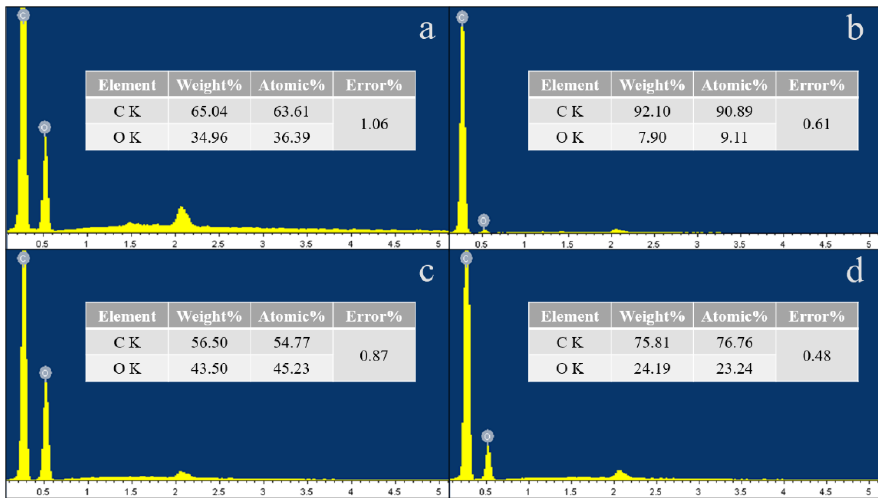
Figure 3. Changes in the oxygen content of PBAT and PS MP particles before and after UV aging (( a ) P-PBAT, ( b ) P-PS, ( c ) A-PBAT, and ( d ) A-PS).